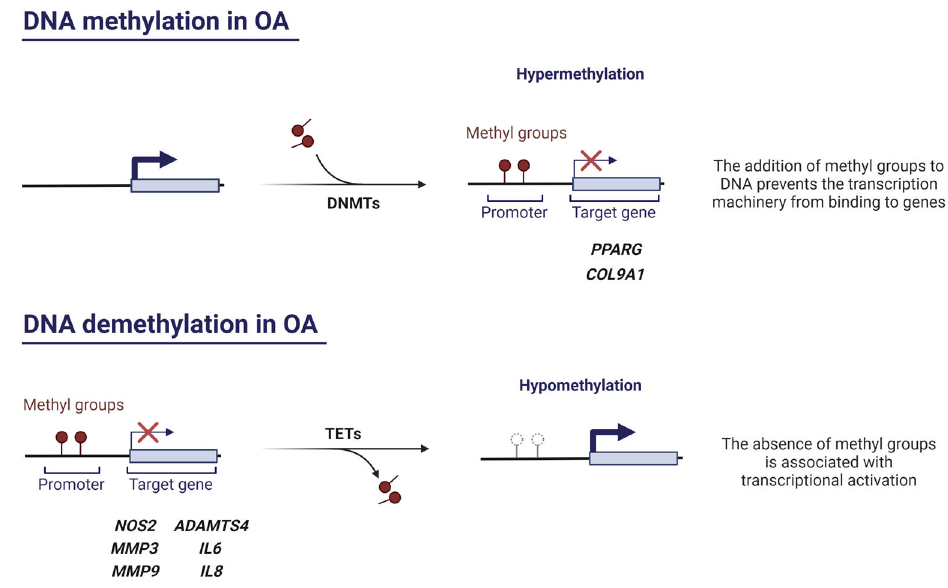
Figure 2. The role of DNA methylation and demethylation in OA. Created with BioRender.com, accessed on 13 January 2023 .